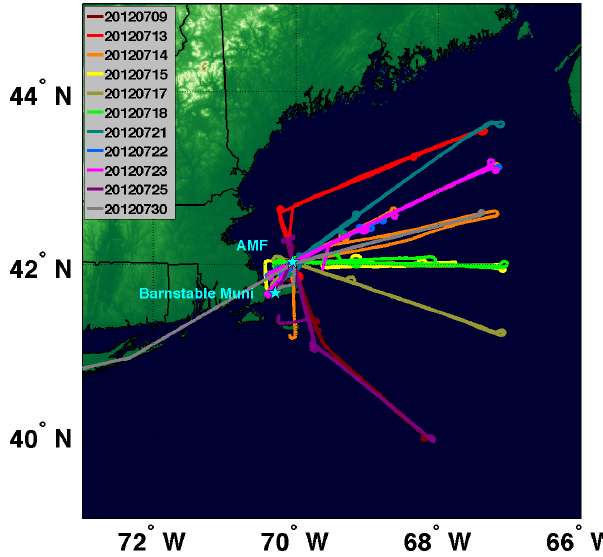
Figure 1. Flight tracks of B-200 King Air during TCAP 2012. Flight days are given in the legend. Each flight took approximately